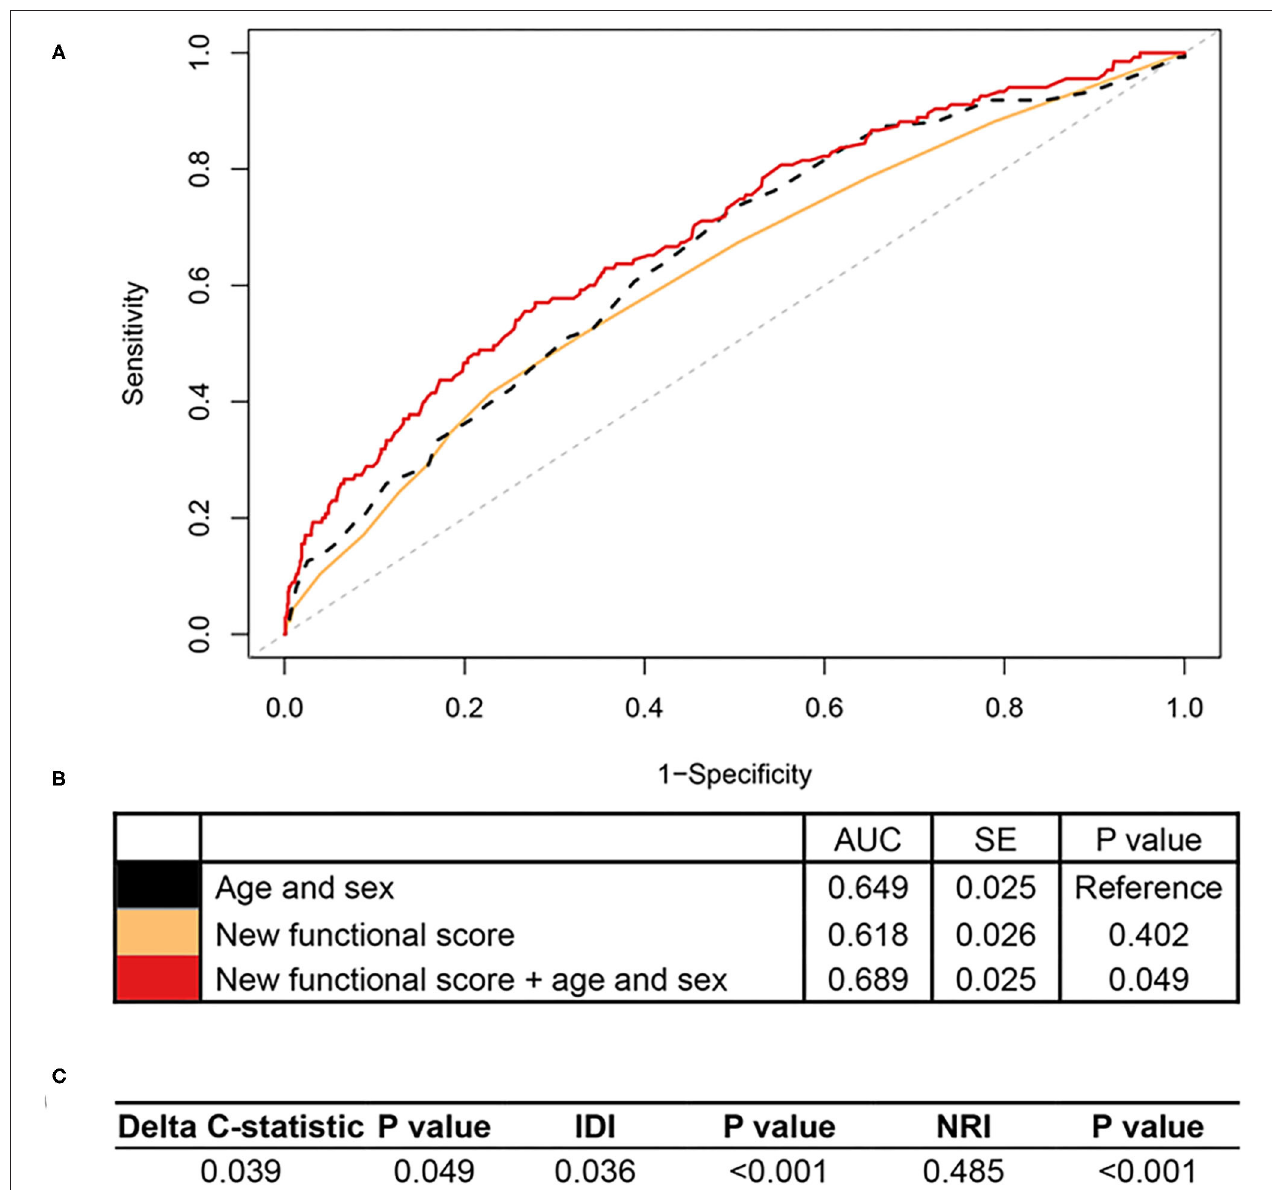
FIGURE 2 | Association of the new functional score with all-cause mortality in RLAS. RLAS, Rugao Longitudinal Aging Study; AUC, area under the curve; SE, standard error; IDI, integrated discrimination improvement; NRI, net reclassification index. We calculated the continuous NRI and IDI using R package “PredictABEL,” in comparison to that of the basic model with age and sex. NRI equals to x% means that compared with persons without outcome, persons with outcome were almost x% more likely to move up a category than down. IDI equals to x% means that the difference in average predicted risks between the persons with and without the outcome increased by x% in the updated model. (A) Shows receiver-operator characteristics curves for prediction of all-cause mortality for the new functional score. (B) Shows the AUC for each model. (C) Shows delta C-statistic, IDI, and NRI, in comparison to that of the basic model with age and